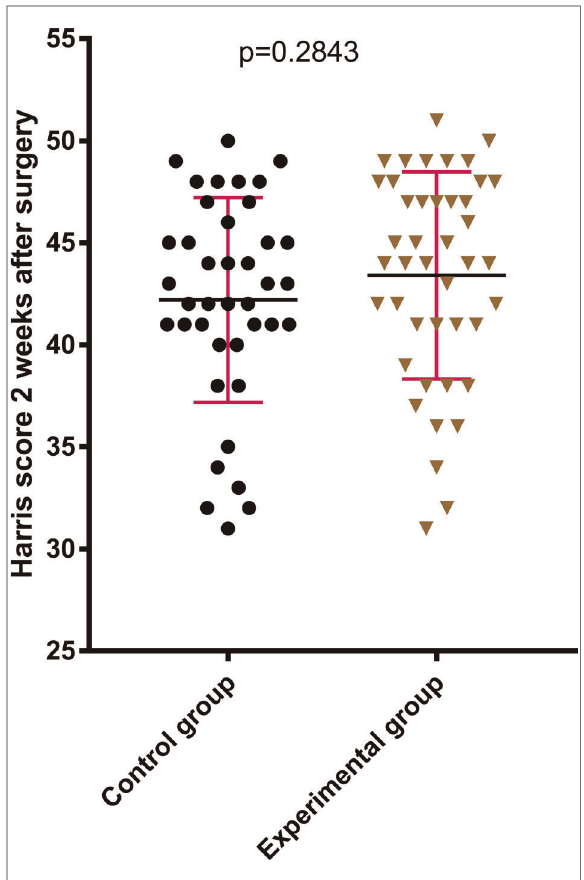
FIGURE 3 There was no signi fi cant difference between the two groups in terms of the Harris score of the hip at 2 weeks after surgery.